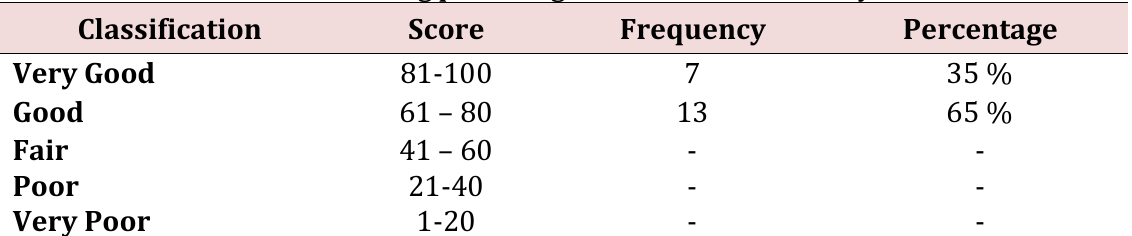
Table 7. The rating percentage of students' score in cycle 2